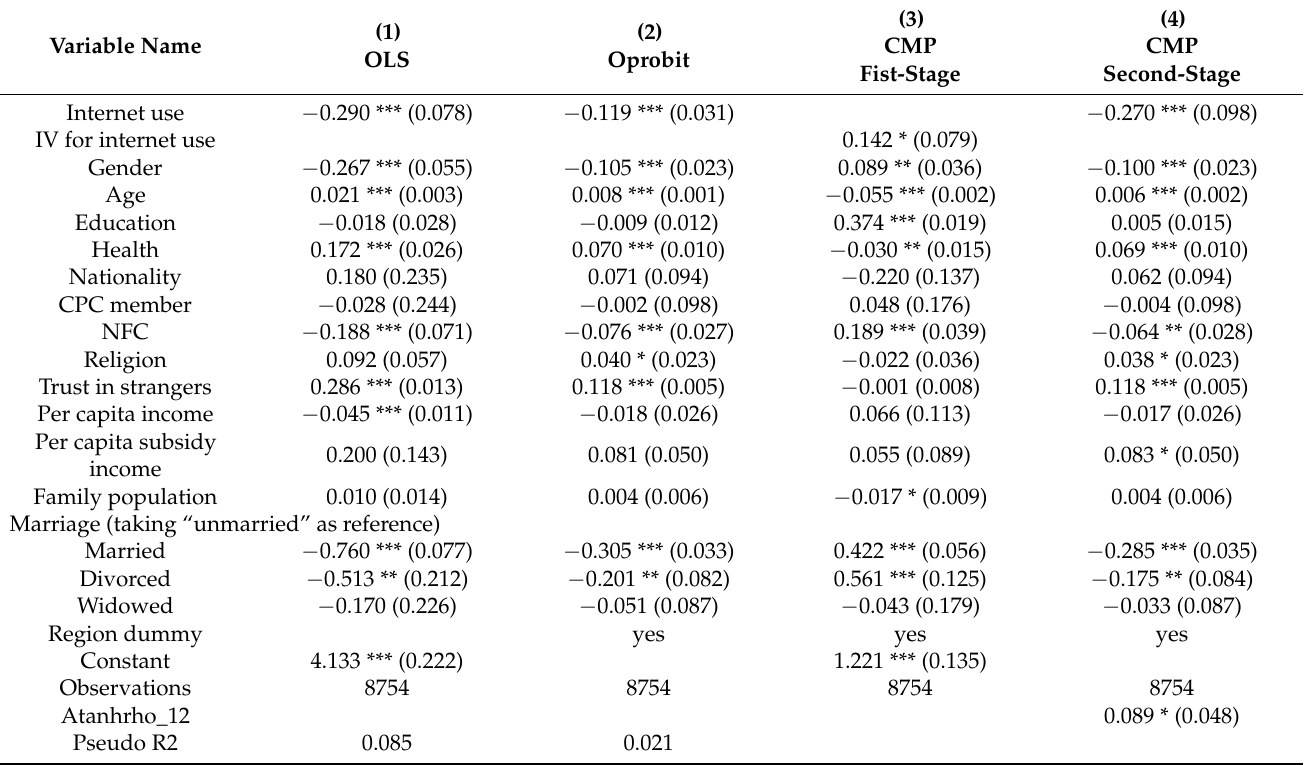
Table 2. Impacts of internet use on farmers’ trust in local